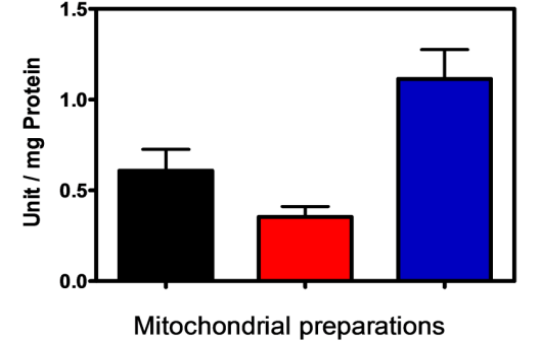
Figure 2. PPX activity in mitochondrial preparations. PPX activity was measured in mitochondria (black bar), soluble (red bar) and membrane fractions (blue bar) of the eggs on the 9th day of development using polyP as substrate. The activity was expressed as 3 units per milligram of total protein and the results represent mean ± SD. of three independent experiments, in triplicate.